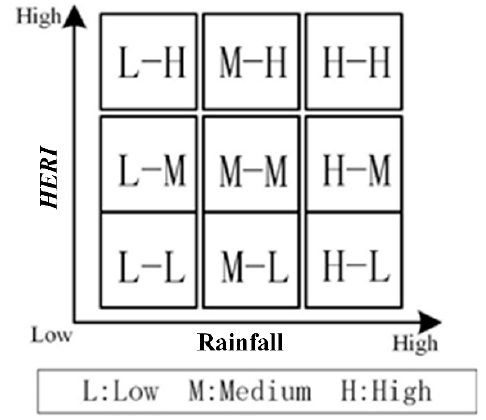
Figure 3. The 9 relationships of ENRR.